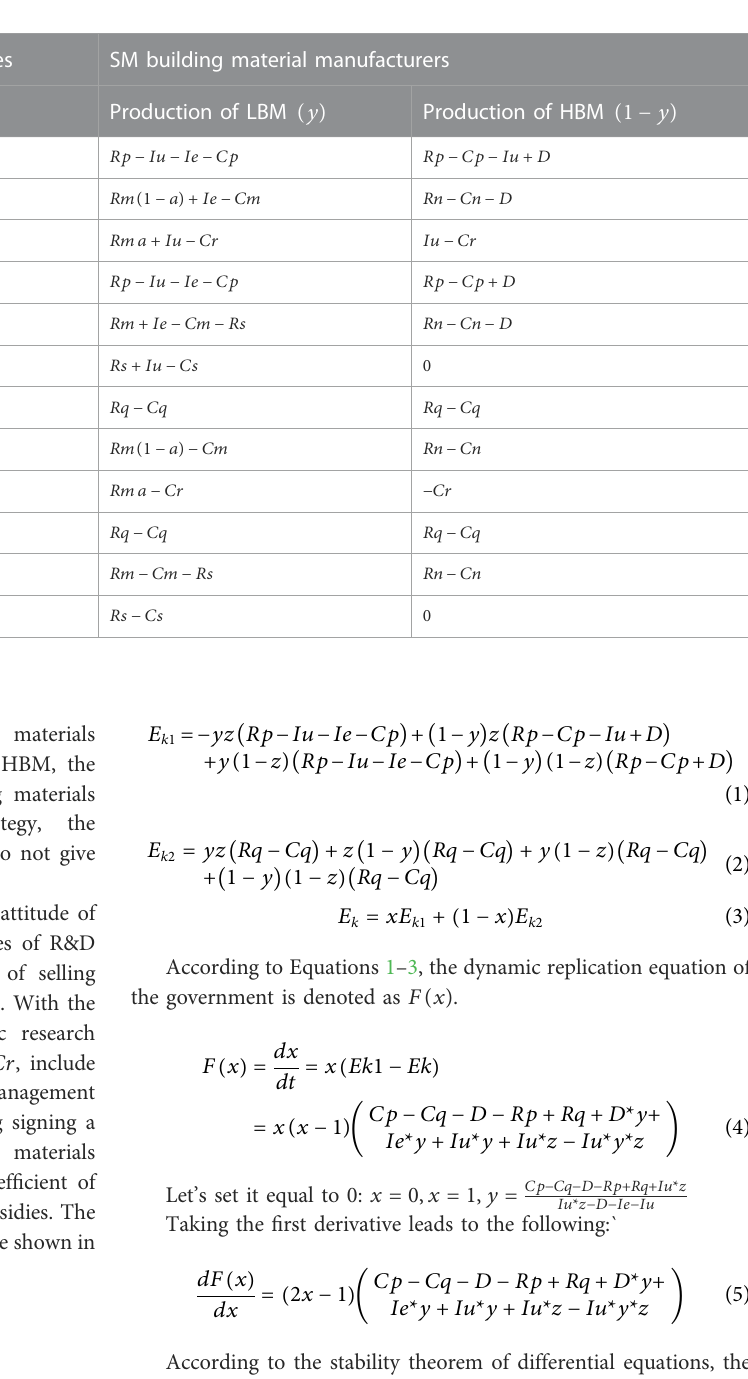
(Figure 2B), then dF ( x ) dx